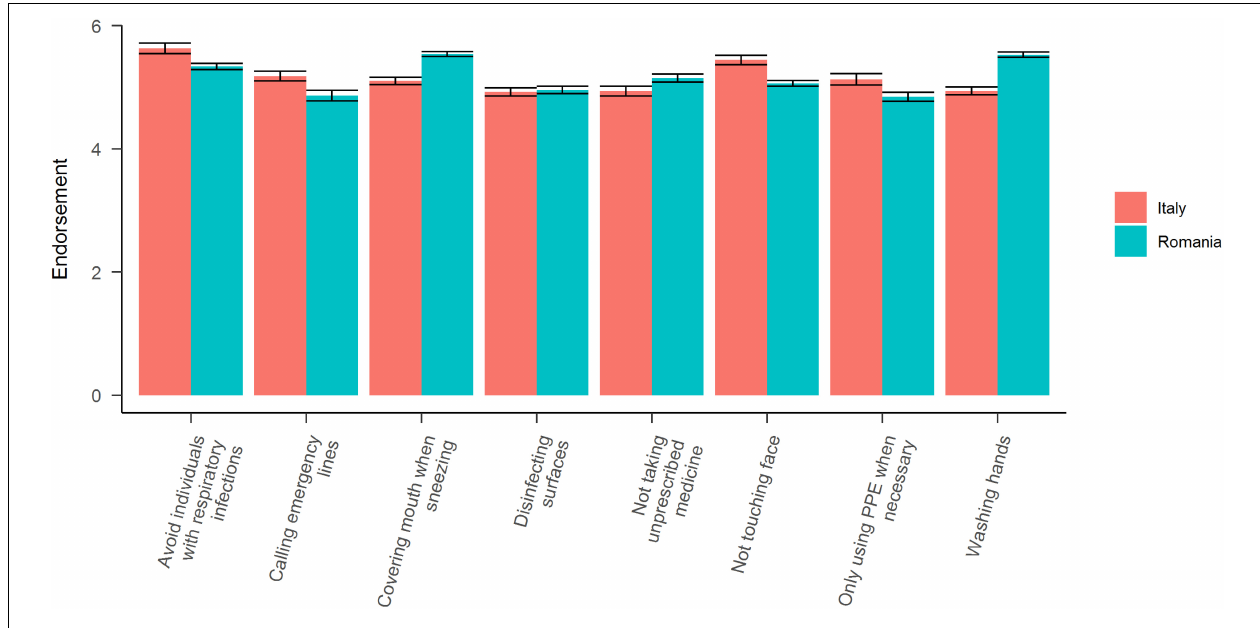
FIGURE 2 | Self-reported practice of behaviors aimed at reducing the spread of COVID-19. All error bars represent 95% CI corrected for within-subjects comparisons. All behaviors were standardized within participants and normalized across countries to increase the